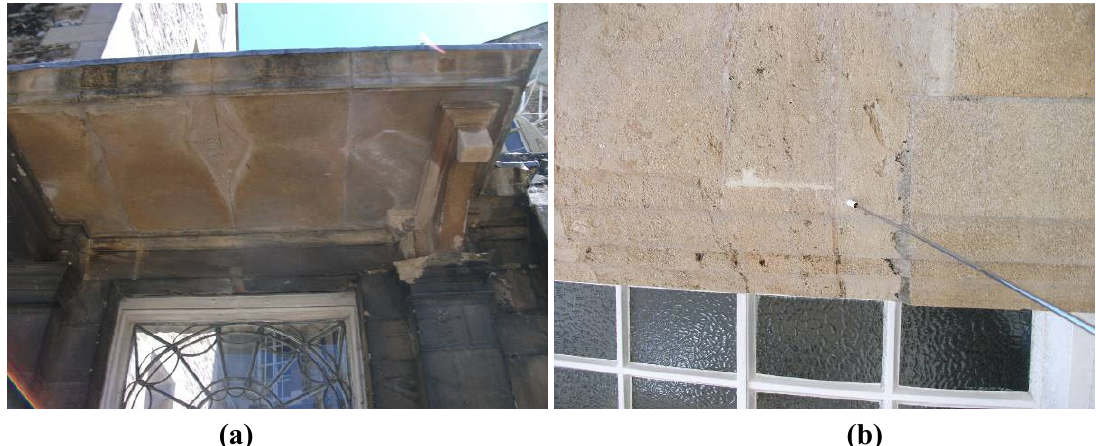
Figure 10. Evidence of ( a ) salt weathering through efflorescence and ( b ) complexity of the weathering situation (complex representation), including pitting, flaking, and human